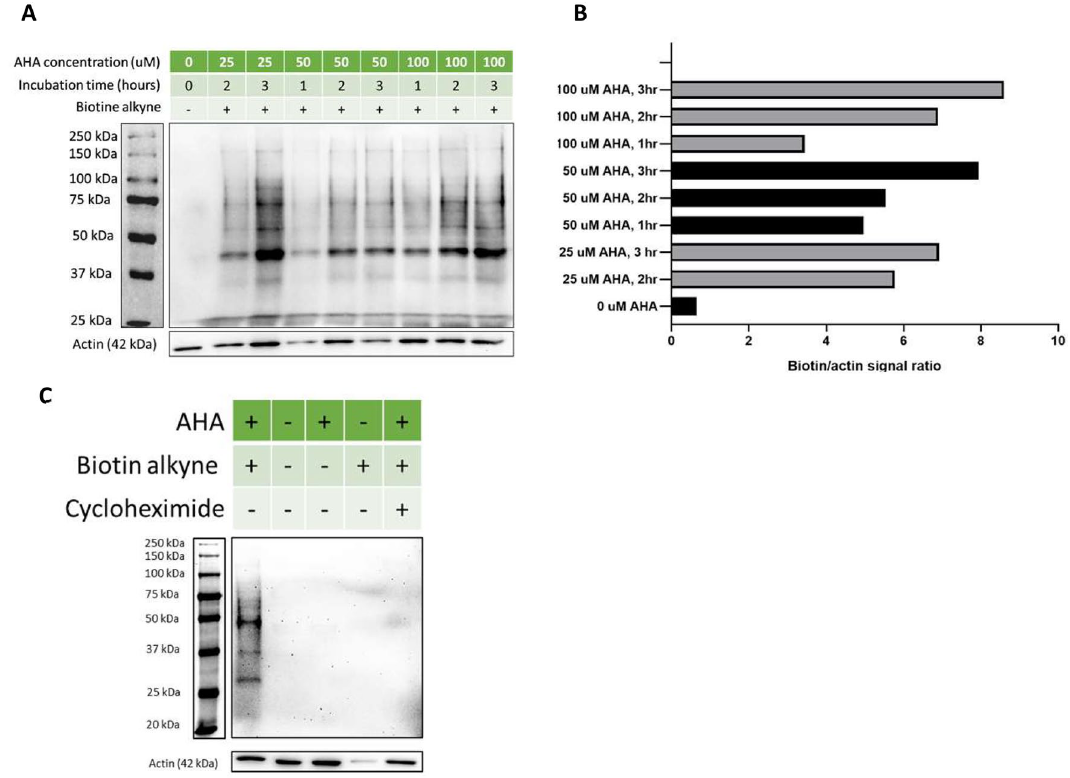
Figure 1. Determination of the optimal AHA labelling condition. ( A ) Anti-biotin Western Blot of protein extracts obtained from PBMCs under different AHA labelling conditions. ( B ) Quantification of the biotin signal obtained by Western blot. Biotin signal intensities were normalized with the corresponding actin signal. ( C ) Specificity of the AHA labelling and conjugation of the biotin probe towards newly synthesize proteins. Full-length blots for biotin and cropped blots for actin are displayed. Full-length actin blots are displayed in Supplementary Figure 3. Multiple exposures of blots displayed in ( A ) and ( C ) can be found in Supplementary Figures 1 and 2